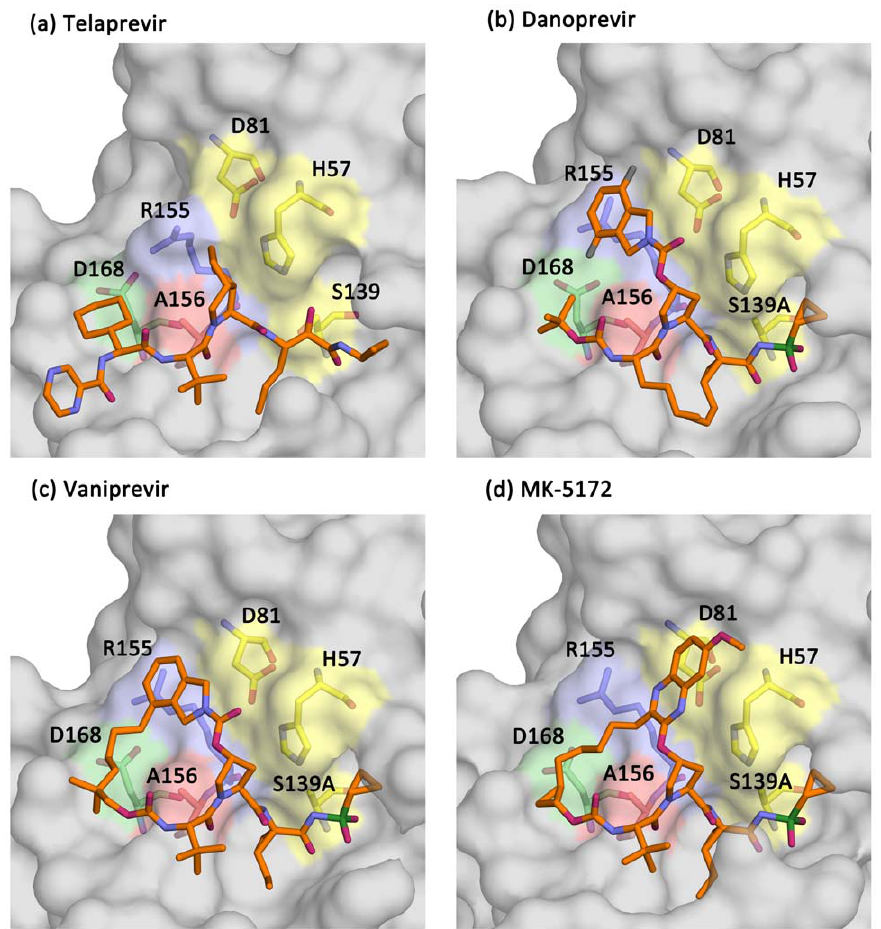
Figure 2. The binding conformations of telaprevir, danoprevir, vaniprevir and MK-5172. Surface representations of the wild-type protease in complex with (A) telaprevir, (B) danoprevir, (C) vaniprevir, and (D) MK-5172. The catalytic triad is shown in yellow and the R155, A156 and D168 side chains are highlighted in light-blue, pale-green and red, respectively.